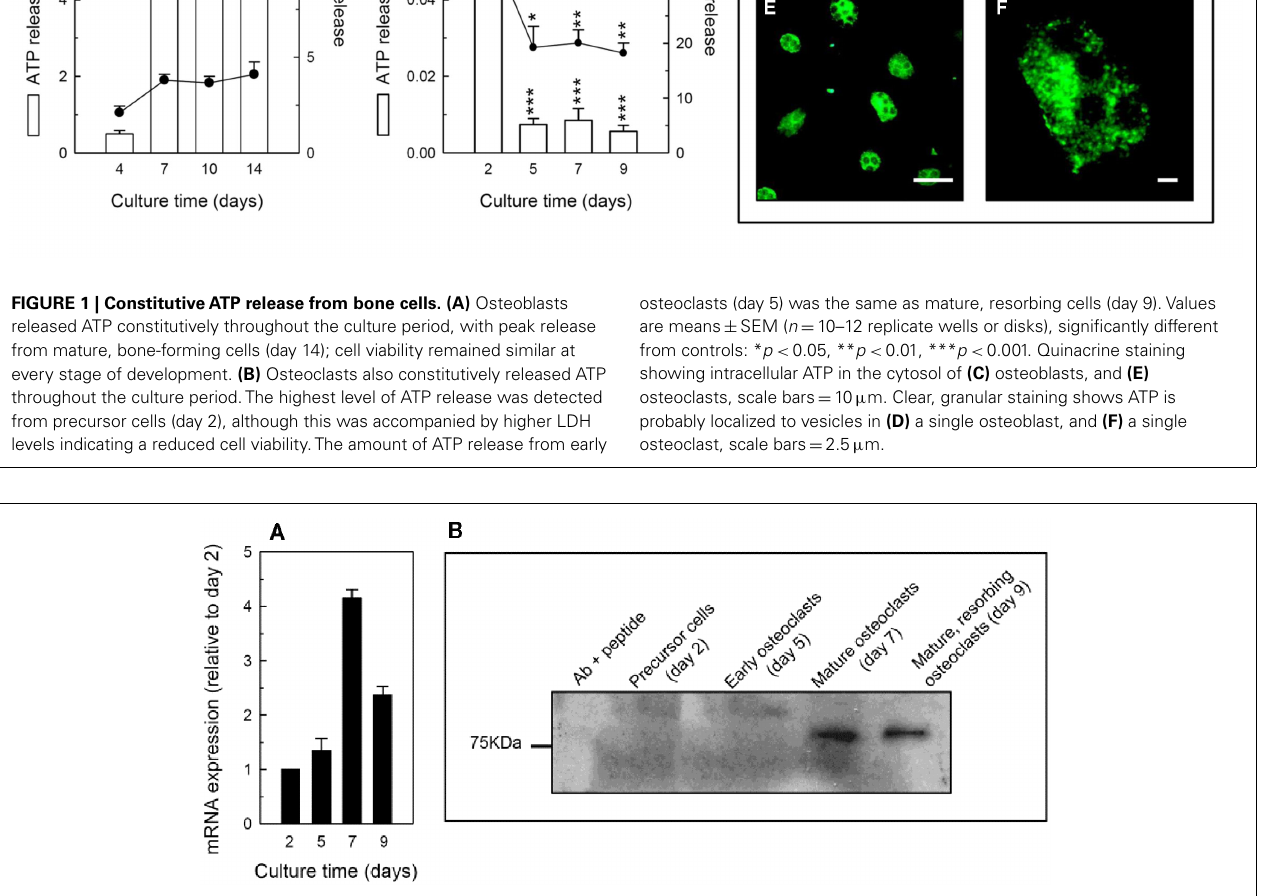
FIGURE 2 | Expression of the P2X7 receptor by osteoclasts. (A) Levels of P2X7 mRNA were increased fourfold in mature osteoclasts relative to precursor cells. Osteoclast activation by acid caused levels of the P2X7 receptor to be decreased in resorbing cells (day 9) compared to mature